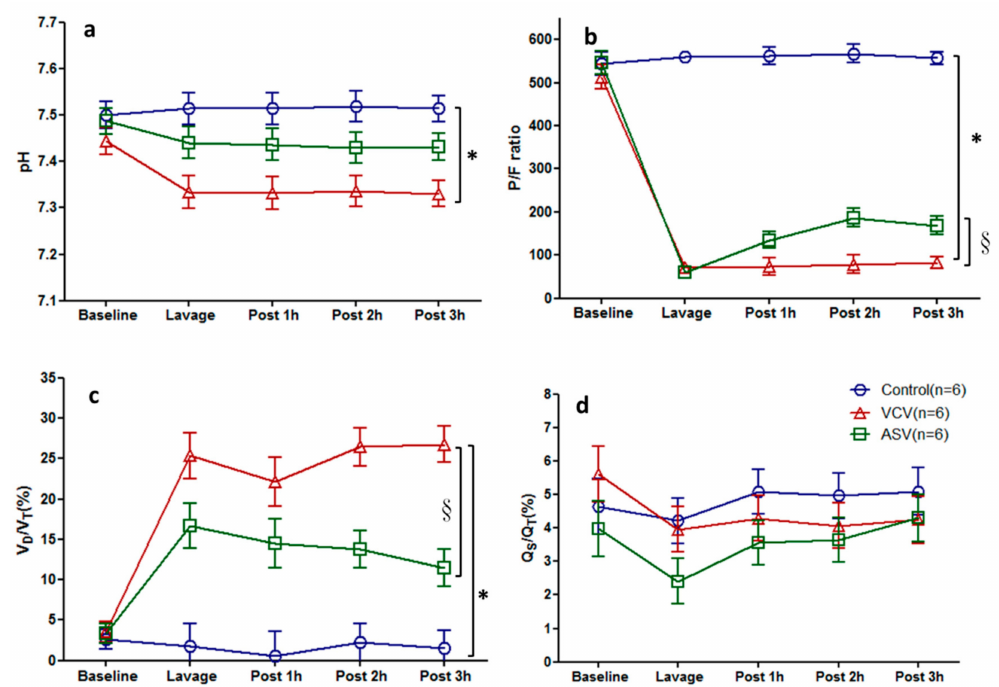
Figure 2. Time course of gas exchange in the three experimental groups ( n = 6 in each group). ( a ) pH, ( b ) P / F ratio, ( c ) dead space ( V D / V T ratio = (PaCO 2 -PetCO 2 ) / PaCO 2 ), ( d ) pulmonary shunt fractions (Qs / Qt = (CcO 2 − CaO 2 ) / CcO 2 − CvO 2 )). The data are presented as the mean ± SD. * p < 0.05